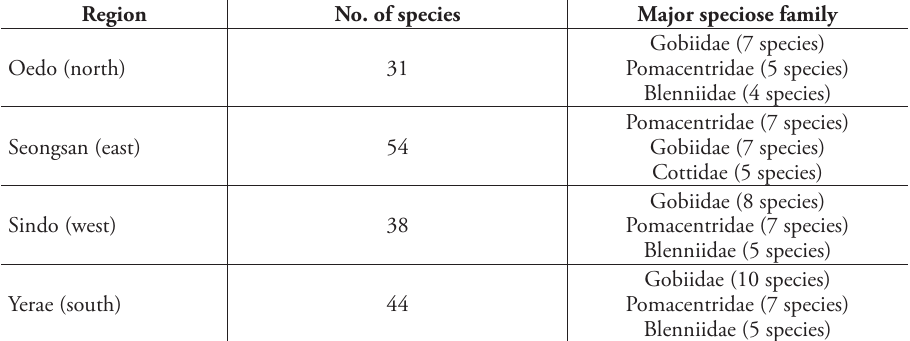
Table 2. Number of fish species and major fish families in tidal pools in four regions of Jeju Island, Korea .